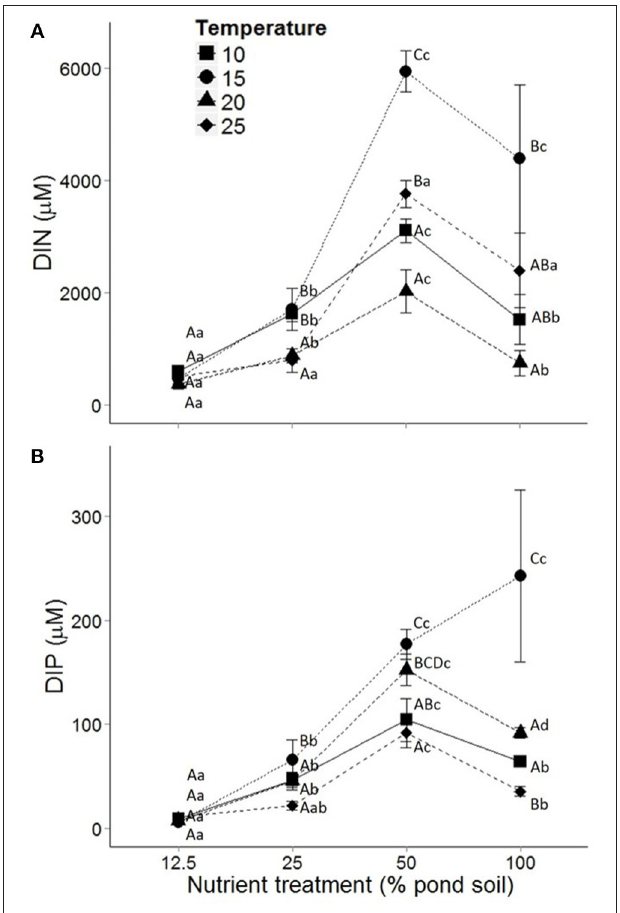
FIGURE 3 | Dissolved nutrient concentrations in the pore water in response to sediment nutrient content, with dissolved inorganic nitrogen (DIN) (A) and dissolved inorganic phosphorus (DIP) (B) at the end of the experiment. Temperature treatments include 10 ( (cid:4) ), 15 ( • ), 20 ( N ) and 25 ( (cid:7) ) ◦ C. Dots represent means and error bars standard error of the mean. Capital and lower case letters indicate post-hoc differences between temperature and nutrient treatments, respectively.